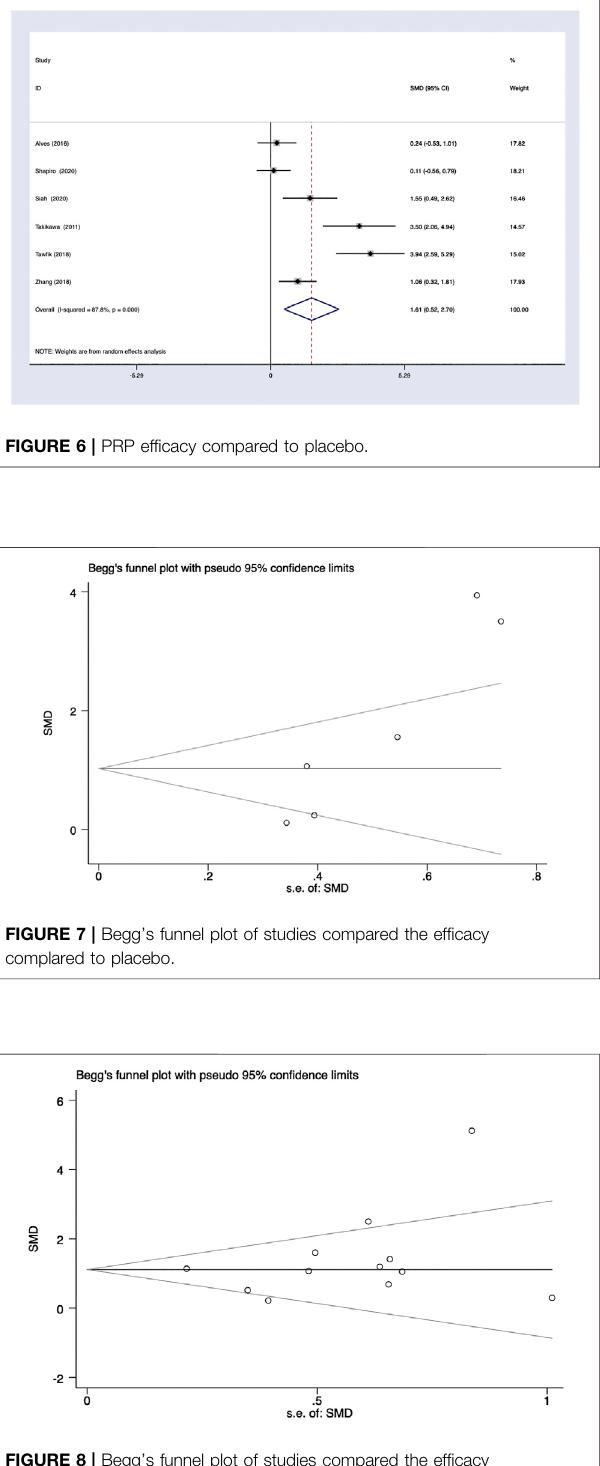
FIGURE 8 | Begg ’ s funnel plot of studies compared the ef fi cacy complared to the baseline.